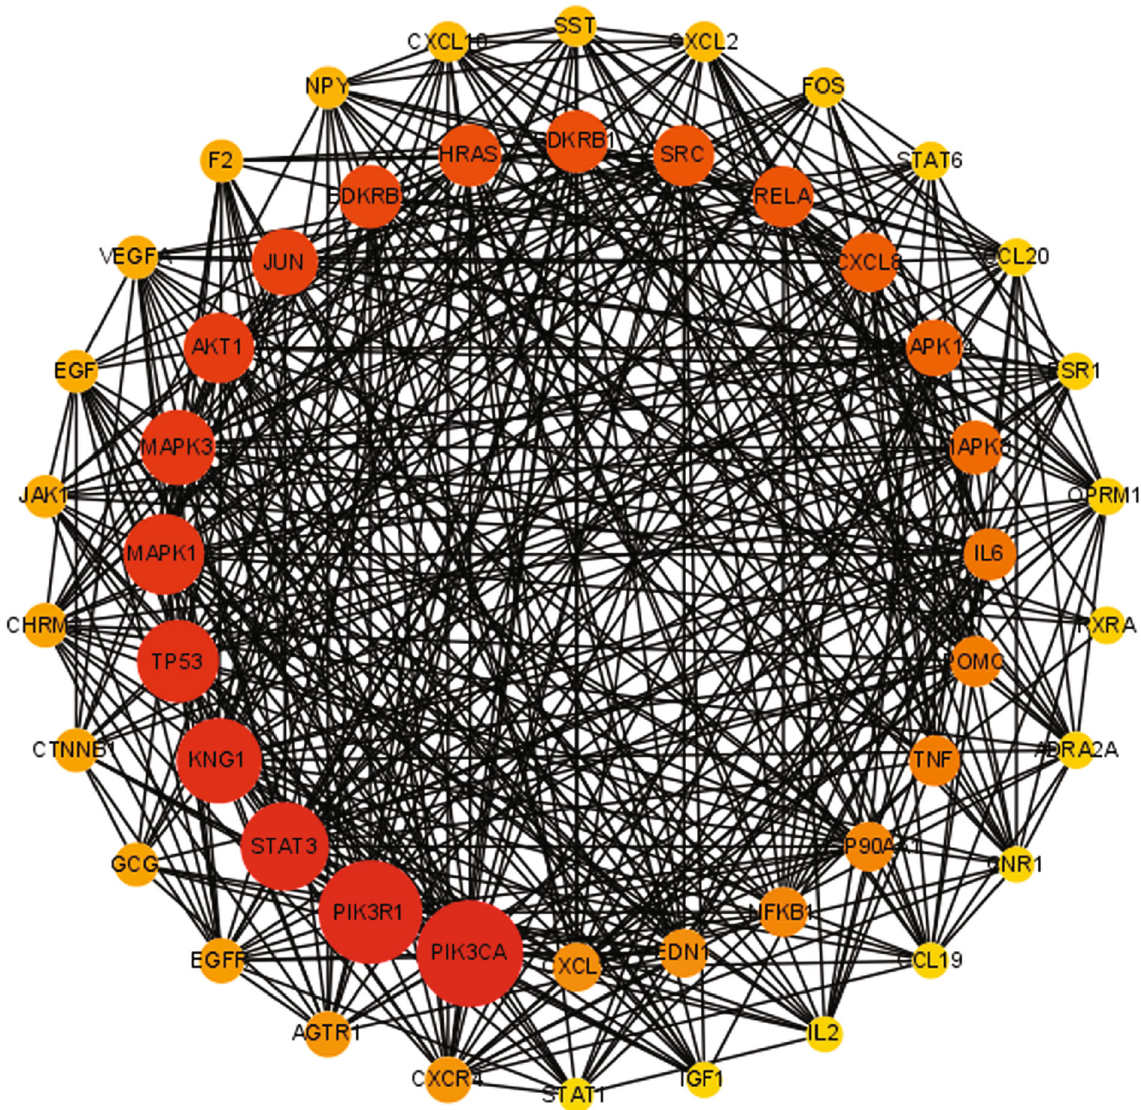
Figure 3: PPI network of top 50 potential genes. As the degree of the target genes increased, the color becomes darker and the circle becomes